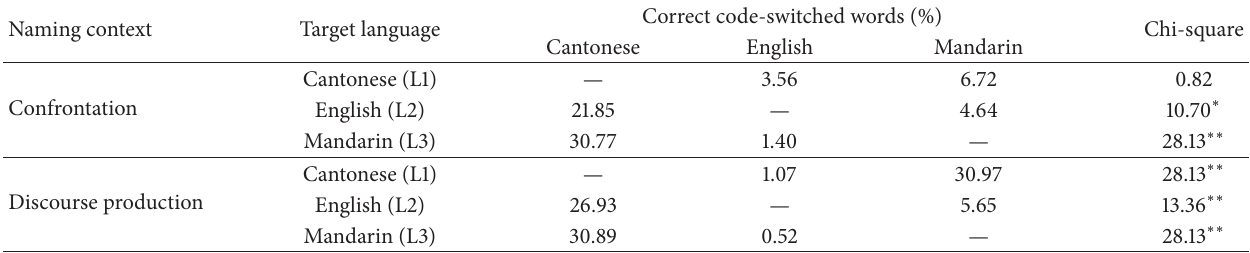
Table 1: Pairwise comparison of code-switched words (%) across naming contexts.